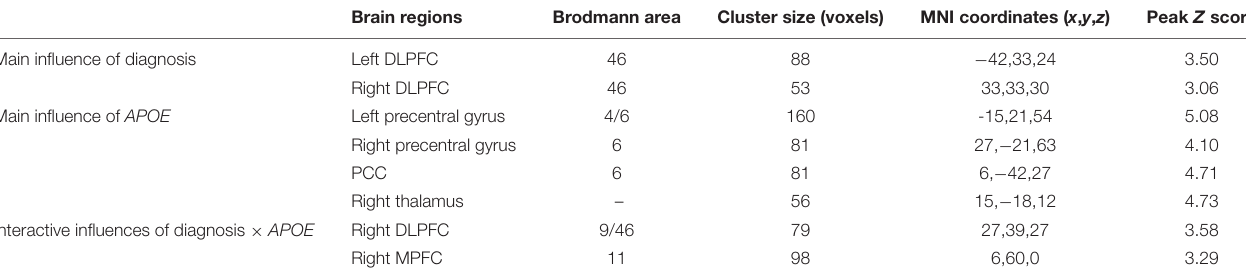
TABLE 2 | Brain areas with significant diagnosis, APOE , and diagnosis × APOE influences on global functional connectivity